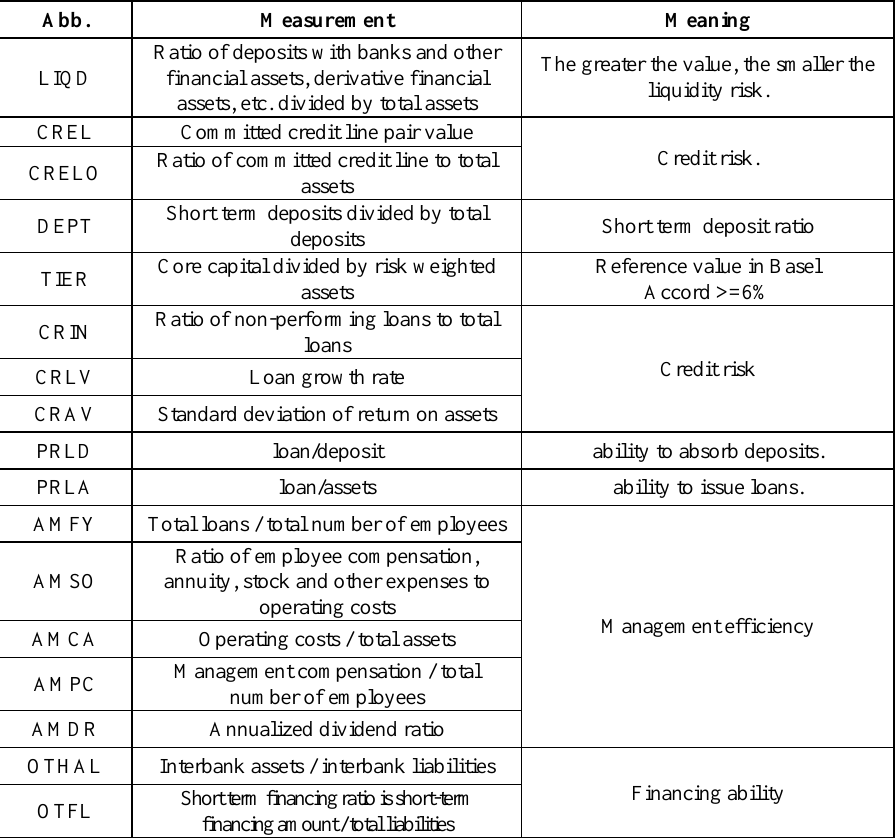
Table 2. List of abbreviations, calculations and meanings of